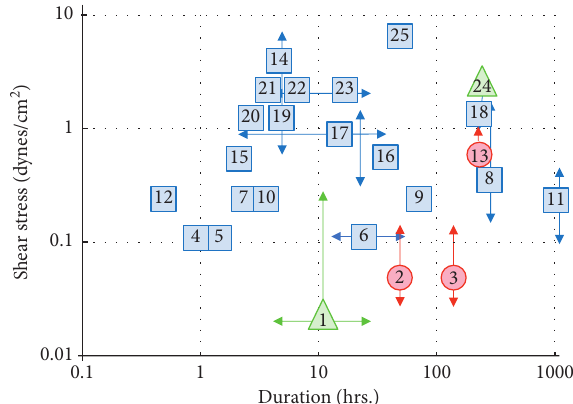
Figure 1: Varying conditions used to expose PTC to shear stress in vitro. The graph illustrates the varying intensity and duration of shear stress applied to cultured PTC from 25 reports in the lit- erature. The y -axis is the intensity of shear force in dynes/cm 2 , and the x -axis is the duration of the exposure in hours. When a report used multiple of conditions, arrows indicate the range of intensities, and/or times and the marker is placed at the average value. Each publication is indicated with a number which corresponds to the citation in Table 1. The marker shape indicates the method used to apply the fluid shear stress: blue squares are parallel plates and microfluidics, red circles are rotating wall suspension culture, and green triangles are stirring bioreactors and orbital